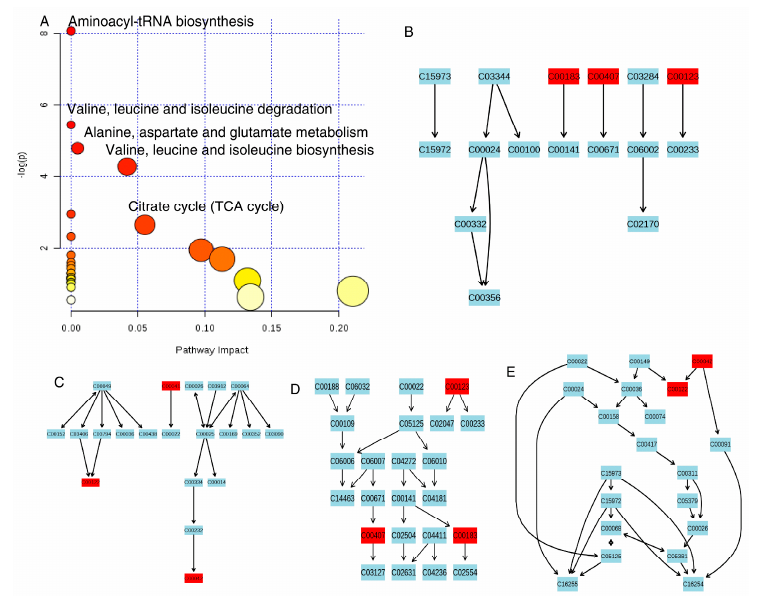
Figure 6. Pathway topology analysis associate with antifungal activities was carried out by MetaboAnalyst in this study ( A ); The term “log P” is the transformation of original p -value calculated from the enrichment analysis and the term “Impact” is the pathway impact value calculated from the pathway topology analysis. Bubble area is proportional to the impact of each pathway, with color denoting the significance from highest in red to lowest in white. Valine, leucine, and isoleucine degradation ( B ); Alanine, aspartate, glutamate metabolism ( C ); Valine, leucine, and isoleucine biosynthesis ( D ); citrate cycle (TCA cycle) ( E ).